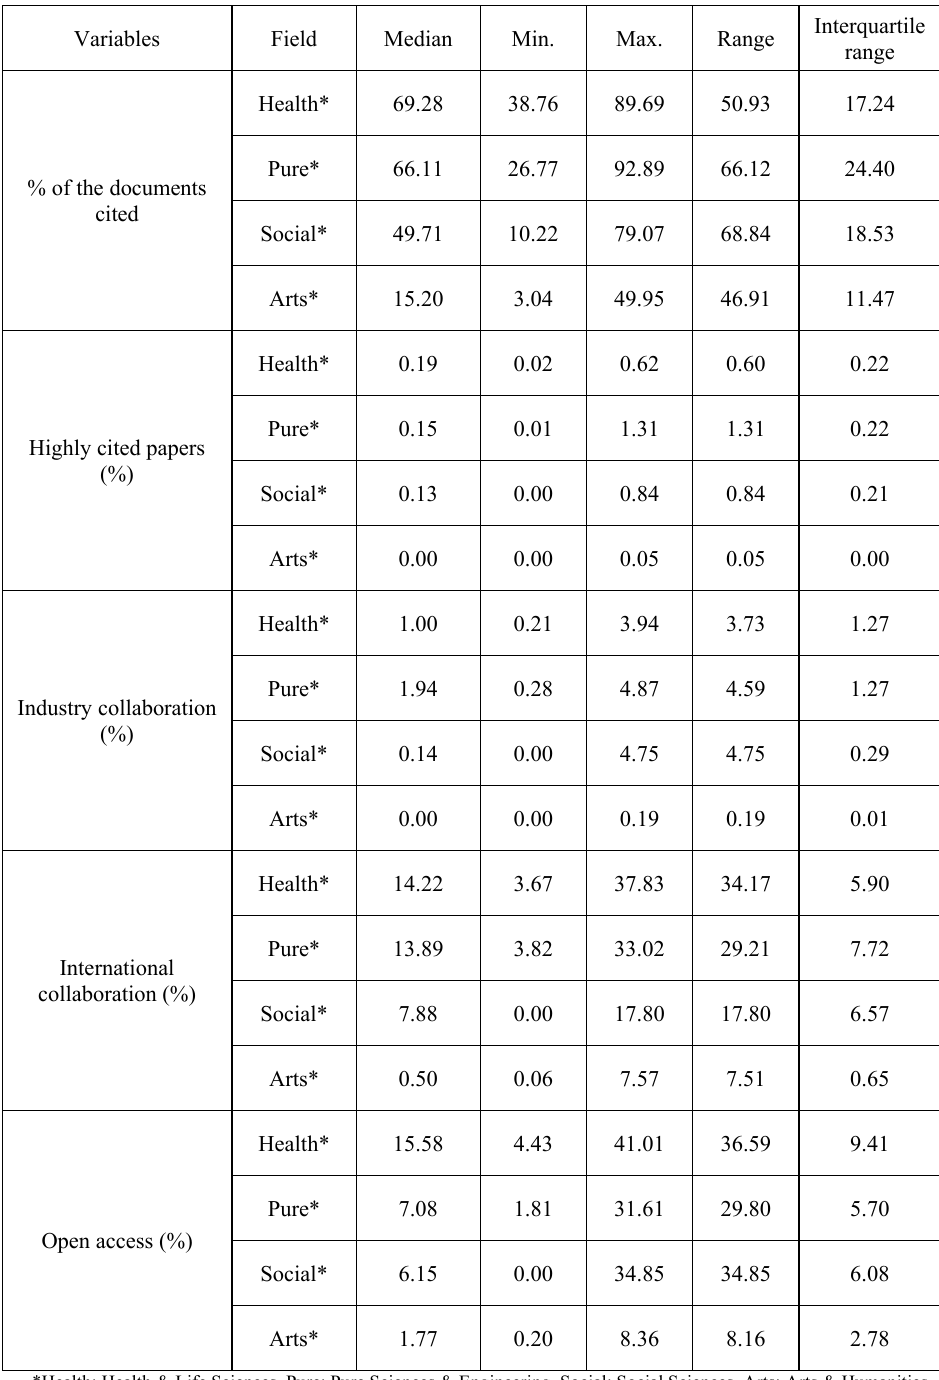
Table 4. The descriptive statistics for other variables in terms of four different